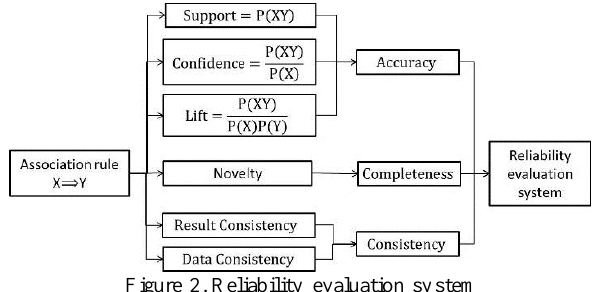
Figure 2. Reliability evaluation system